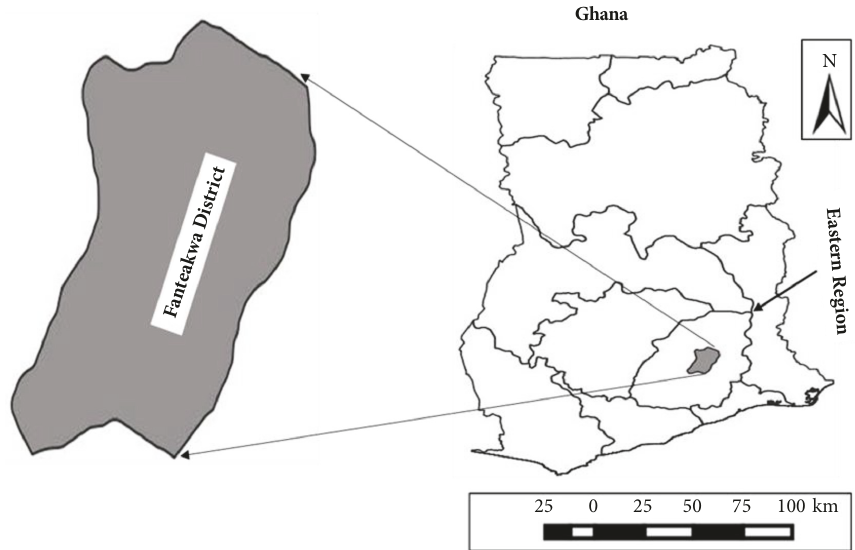
Figure 1: A map of Ghana showing Fanteakwa district in the Eastern Region of